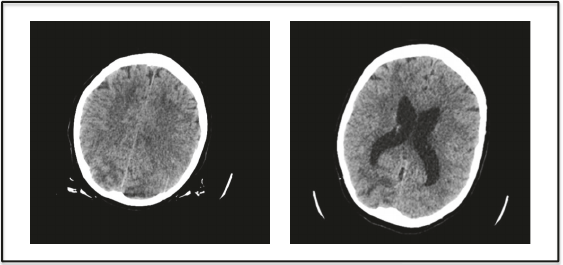
Figure 2: Brain CT-scan showing widespread bilateral asymmetri- cal hypodensities in the cortex and subcortical regions.